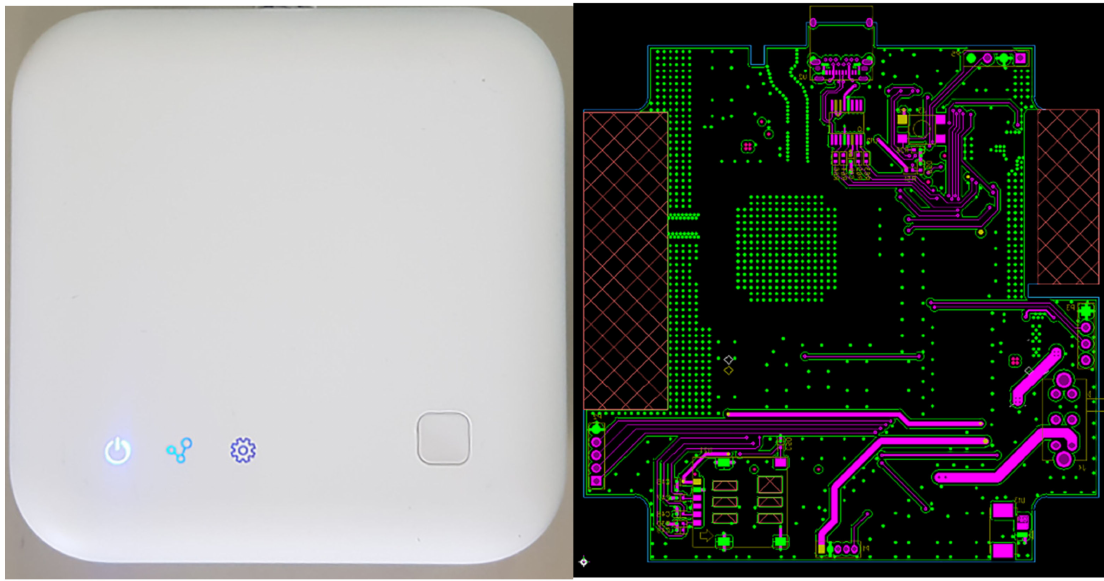
Figure 14. IoT AP prototype with the ability of LTE communication.